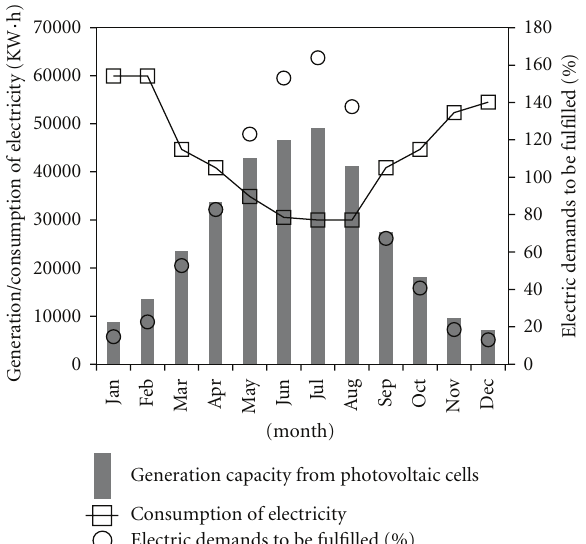
Figure 6: Monthly dynamics of “to be generated” amount of electricity from solar energy and the actual electricity consumption and the discrepancies (in the form of